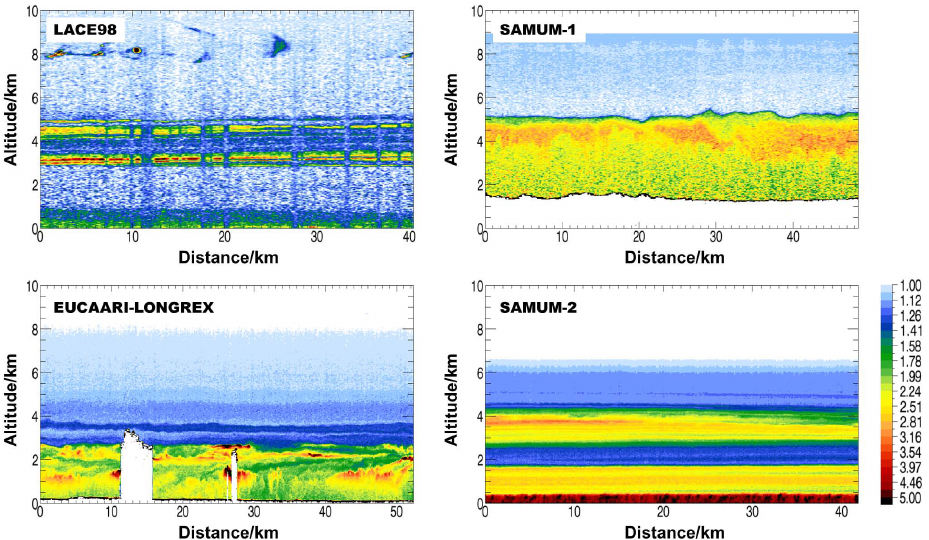
Fig. 4. Selected backscatter ratio cross-sections measured with the HSRL at 532nm on 9 August 1998 (LACE98), 6 May 2008 (EUCAARI- LONGREX), 19 May 2006 (SAMUM-1), and 4 February 2008 (SAMUM-2). Each cross-section is representative for one field experiment and shows the typical vertical structure of the aerosol load during the respective campaign. All cross-sections have the same